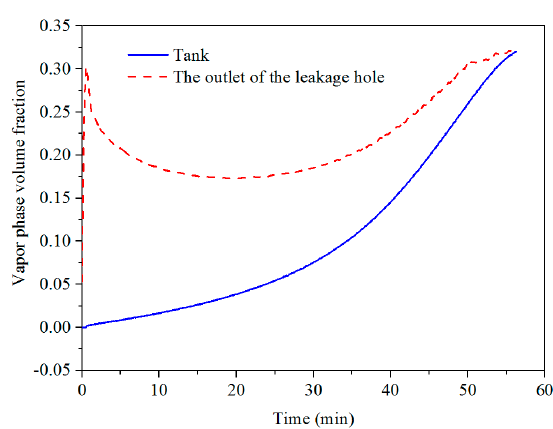
Figure 12. Changes in the vapor phase volume fractions in the tank and at the outlet of the leak hole over time.